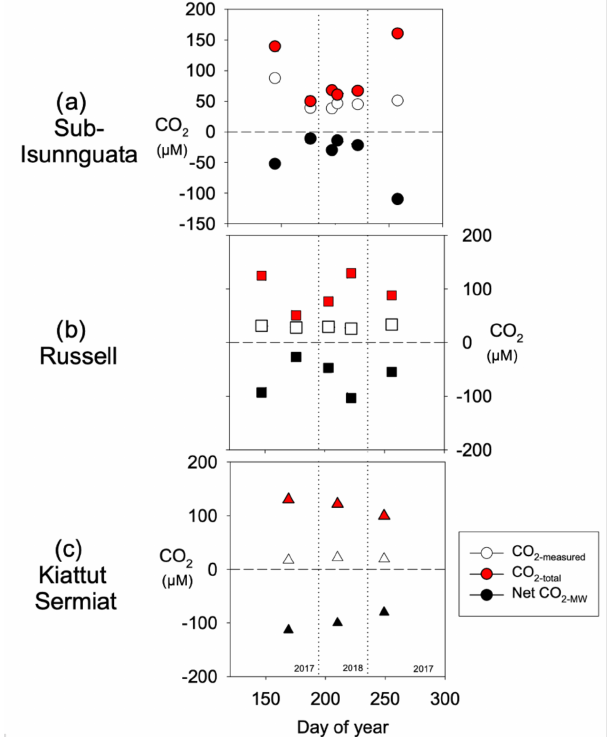
Figure 7. Calculated CO 2-total values for (a) sub-Isunnguata, (b) Russell, and (c) Kiattut Sermiat subglacial discharge against day of the